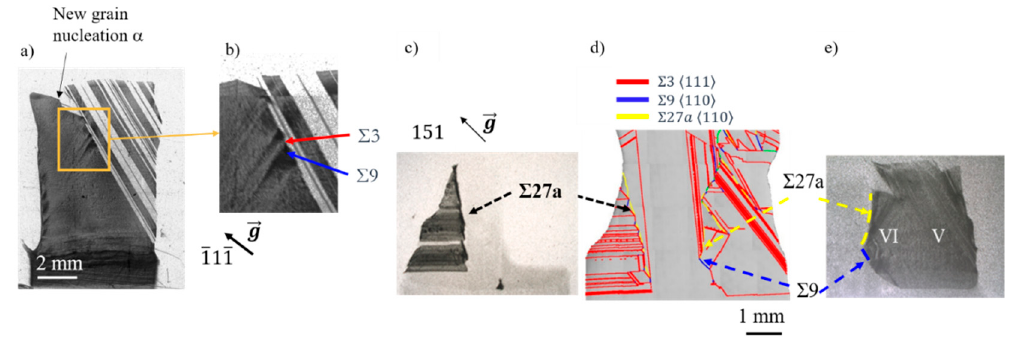
Figure 8. ( a ) Topograph for the experiment in Figure 2, Figure 5a, and Figure 6a. ( b ) Close up at the level of competing twin grains, ( c ) topograph for the experiment in Figure 5b, Figure 6c, and Figure 7b,c, ( d ) corresponding coincidence site lattice map, and ( e ) topograph of a grain on the right side.